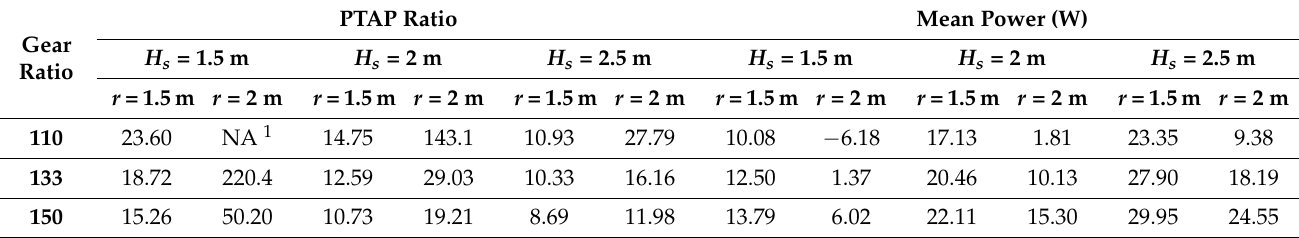
Table 7. PTAP ratio and mean power for an irregular wave with a fixed-peak period ( T p = 11 s).